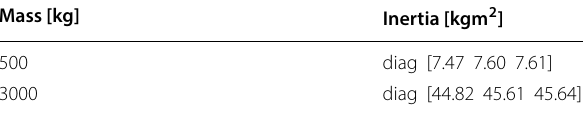
Table 1 Mass and inertia parameters of the